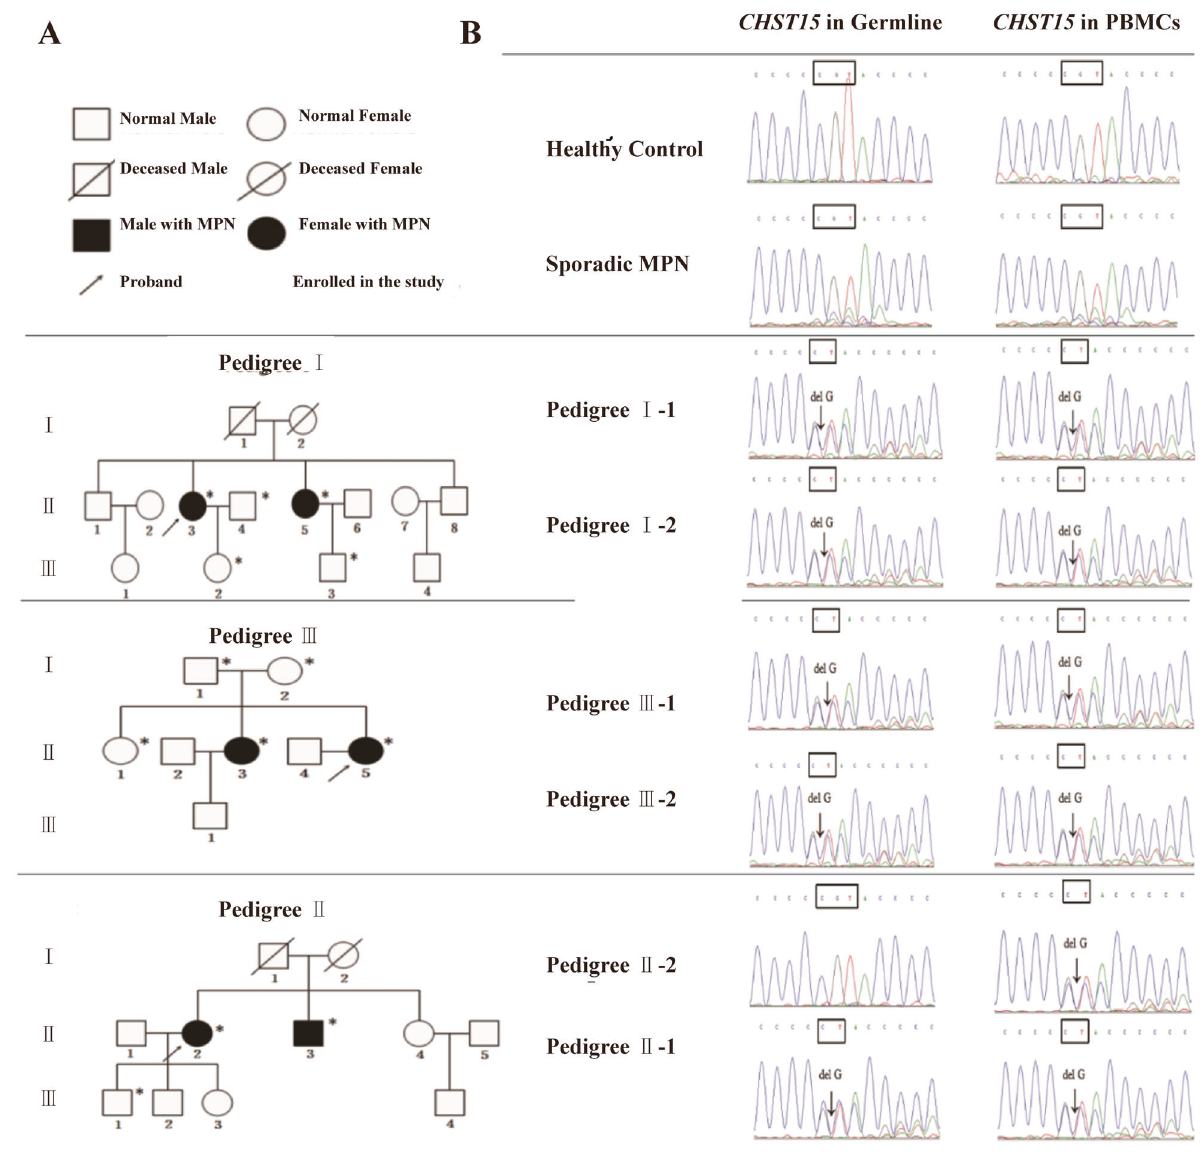
Fig. 1 Pedigrees of the three families MPN and identi fi cation of somatic and germline mutation in CHST15 gene. A Pedigrees of familial MPN. Filled symbols represent affected cases. Oblique line indicates the proband; PMF, primary myelo fi brosis; ET, essential thrombocythemia. B Sanger sequencing of CHST15 mutation both the somatic cells and the germline